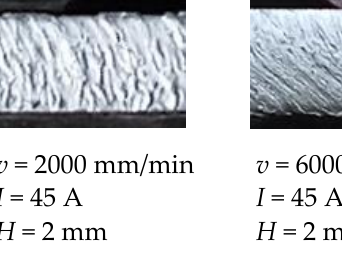
Table 11. Multi-objective optimization